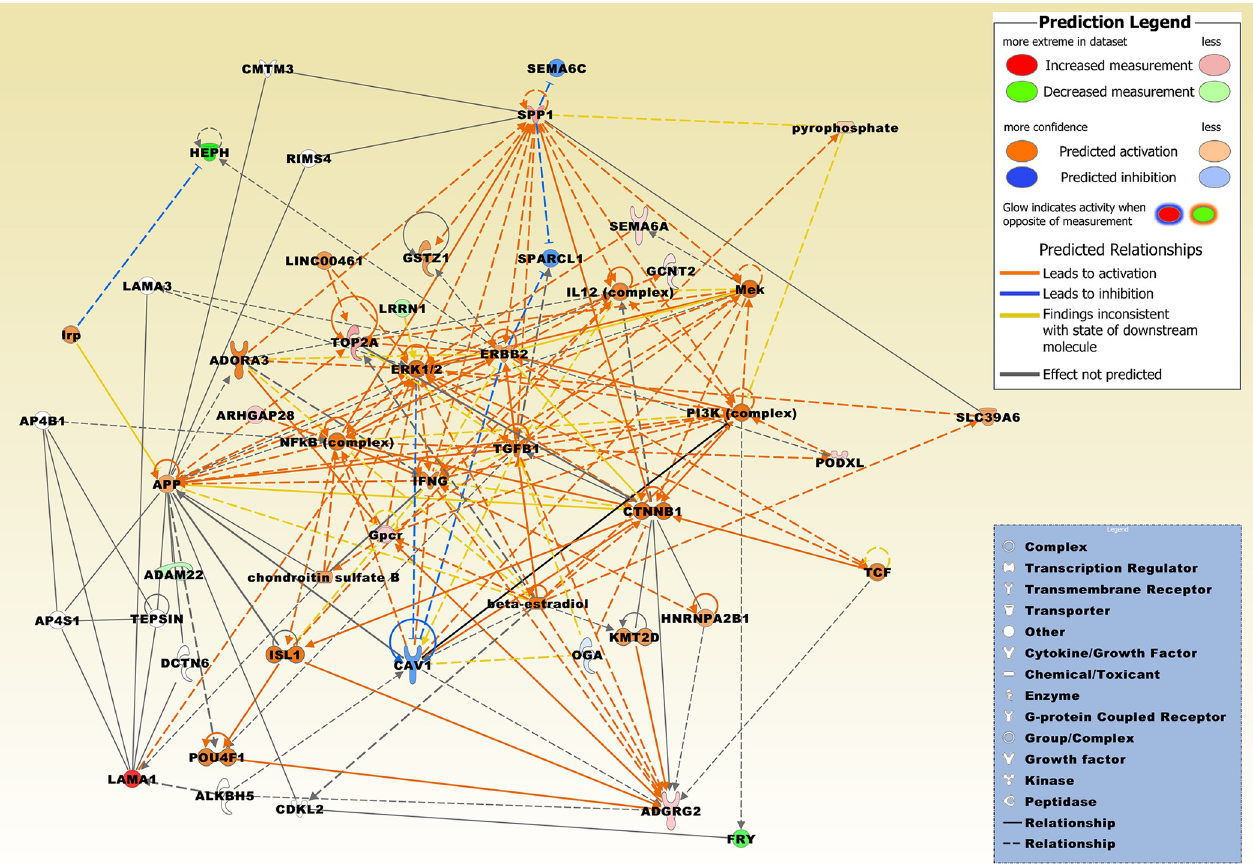
Fig 5. The top two merged networks of genes that were present in at least two different data sets from the GI vs . GII + GIII comparison groups. Genes/ molecules include ADAM22, ADGRG2, ARHGAP28, FRY, GCNT2, HEPH, LAMA1, LRRN1, PODXL, SEMA6A, SPP1, and TOP2A. Integrative network molecules comprise, adenosine A3 receptor (ADORA3), alkB homolog 5, RNA demethylase (ALKBH5), adaptor related protein complex 4 subunit beta 1 (AP4B1), adaptor related protein complex 4 subunit sigma 1 (AP4S1), amyloid beta precursor protein (APP), beta-estradiol, caveolin 1 (CAV1), cyclin dependent kinase like 2 (CDKL2), chondroitin sulfate B, CKLF like MARVEL transmembrane domain containing 3 (CMTM3), catenin beta 1 (CTNNB1), dynactin subunit 6 (DCTN6), erb-b2 receptor tyrosine kinase 2 (ERBB2), ERK1/2, Gpcr, glutathione S-transferase zeta 1 (GSTZ1), heterogeneous nuclear ribonucleoprotein A2/B1 (HNRNPA2B1), interferon gamma (IFNG), IL12 (complex), Irp, ISL LIM homeobox 1 (ISL1), lysine methyltransferase 2D (KMT2D), laminin subunit alpha 3 (LAMA3), long intergenic non-protein coding RNA 461 (LINC00461), Mek, NFkB (complex), O-GlcNAcase (OGA), PI3K (complex), POU class 4 homeobox 1 (POU4F1), pyrophosphate, regulating synaptic membrane exocytosis 4 (RIMS4), semaphorin 6C (SEMA6C), solute carrier family 39 member 6 (SLC39A6), SPARC like 1 (SPARCL1), TCF, TEPSIN adaptor related protein complex 4 accessory protein (TEPSIN), and transforming growth factor beta 1 (TGFB1). S3 Table contains the relationships of